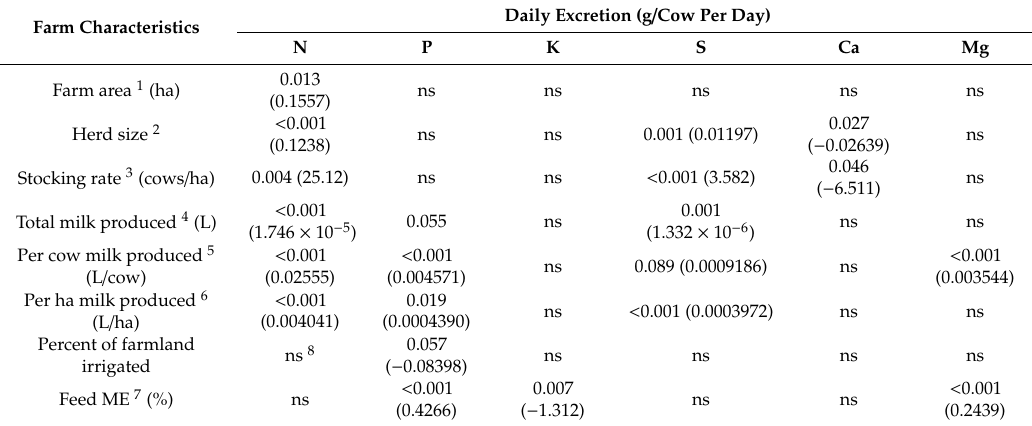
Table 8. F-prob (e ff ects) estimates for residual maximum likelihood (REML) analysis of daily nutrient excretion and characteristics of these grazing system dairy